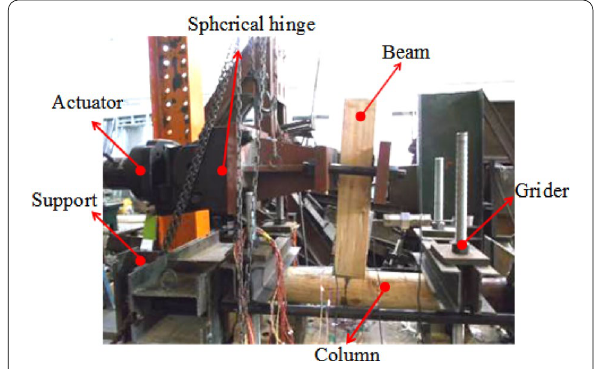
Fig. 19 Test setup